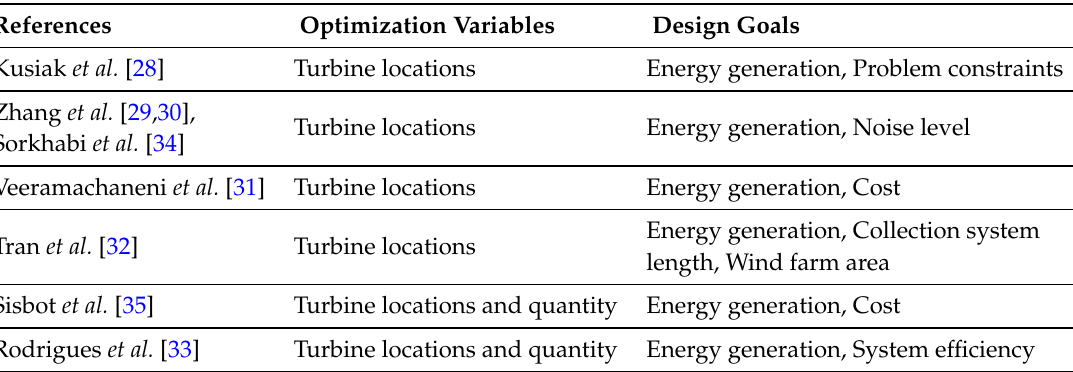
Table 1. Existing approaches for the